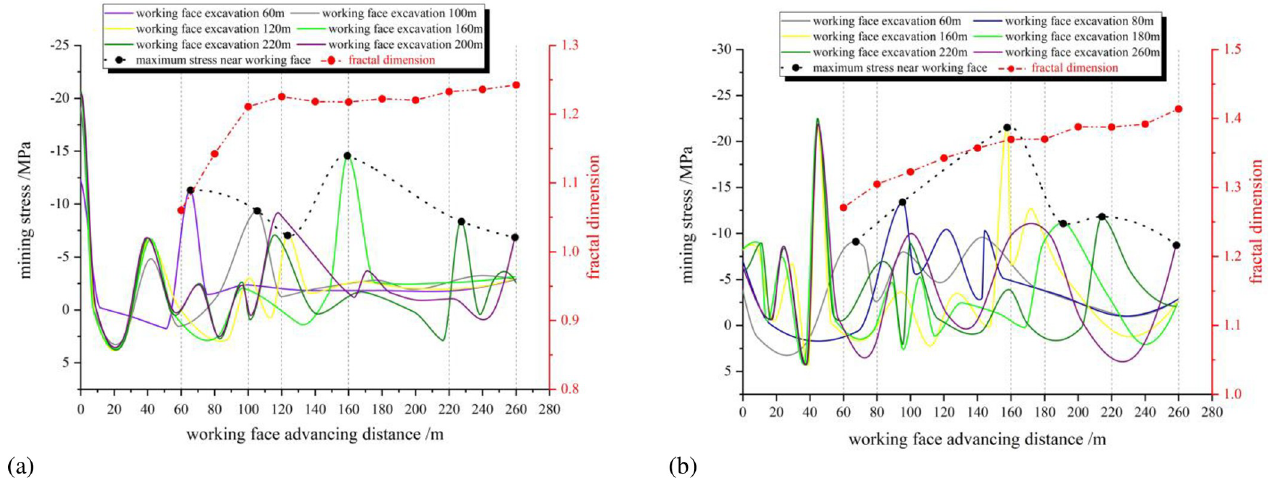
Fig 8. Mining stress and fractal dimension change. (a) 5# coal seam mining; (b) 6# coal seam mining.